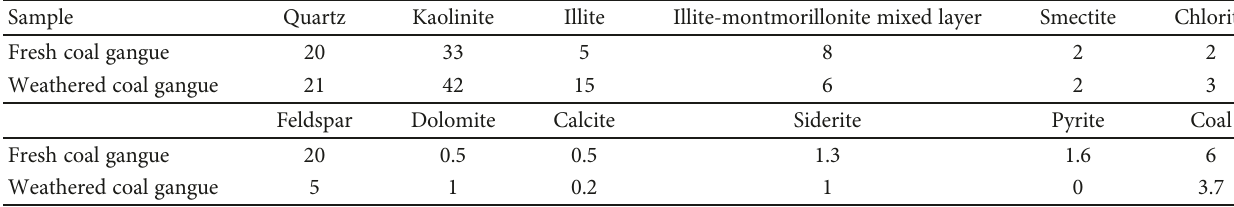
Table 1: Mineral composition of fresh and weathered coal gangue (%).